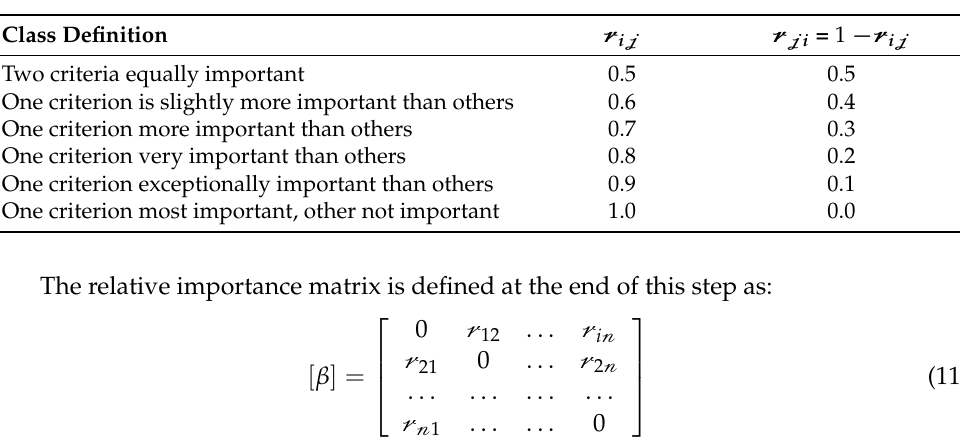
Table 3. The relative importance of